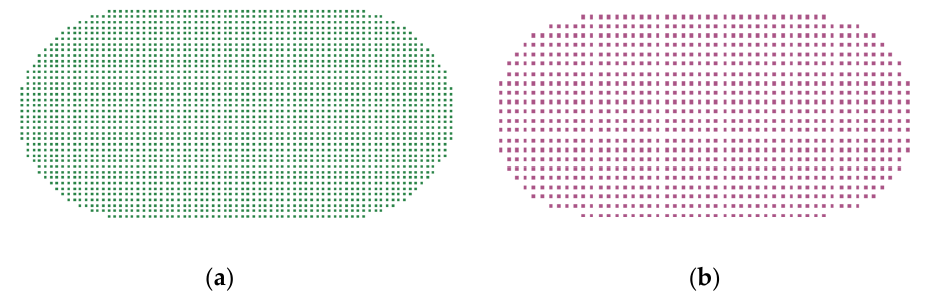
Figure 11. Shape and dimensions of SPH bird model.